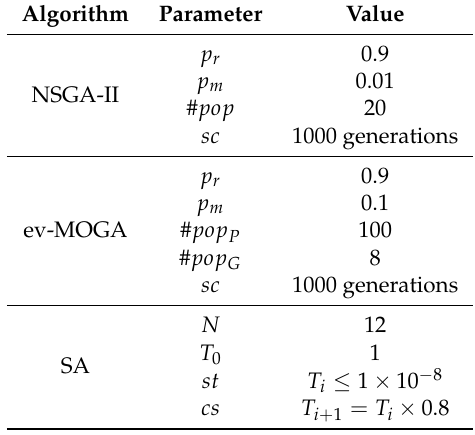
Table 1. Parameter settings for Non-dominated Sorting Genetic Algorithm version II (NSGA-II), Epsilon-Variable Multi-Objective Genetic Algorithm (ev-MOGA) and simulated annealing